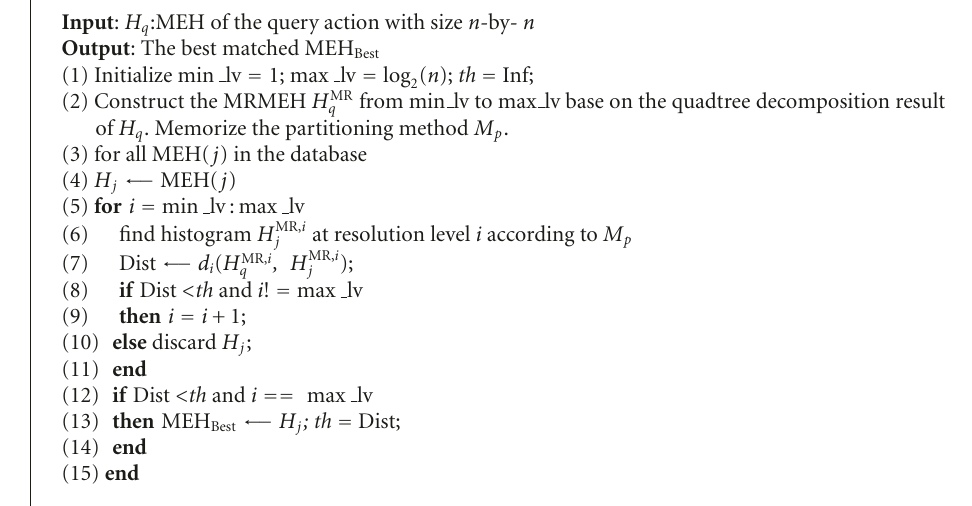
Algorithm 1: Algorithm for action recognition.